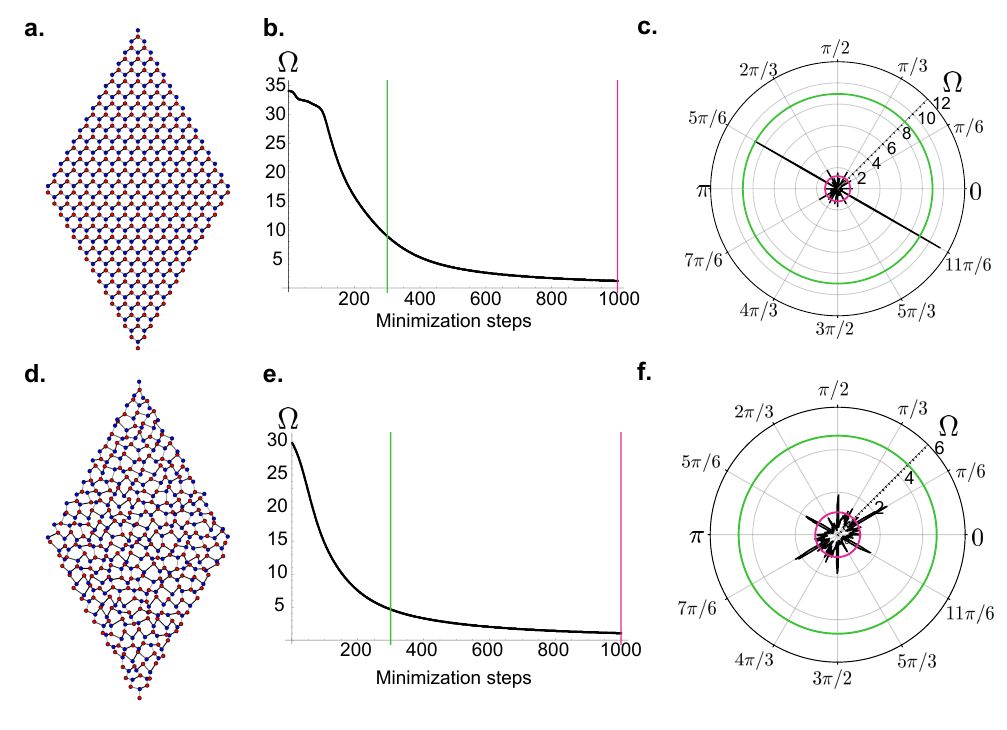
Figure 11: Comparison between the matrix pencil and the MLWF method a. Sketch of the frame geometry for a crystalline chiral honeycomb lattice made of 15 × 15 unit cells.